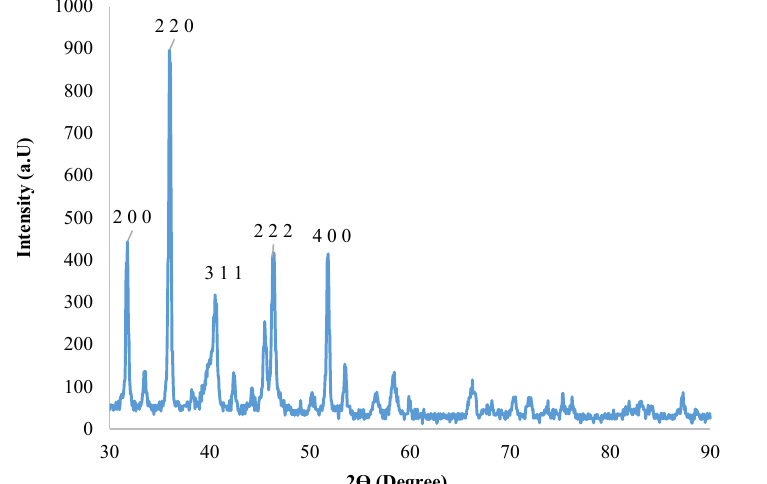
2Ө (Degree) Fig. 2. XRD pattern of palladium oxide nanoparticles